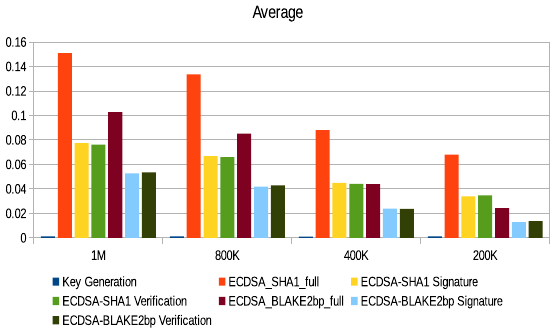
Figure 24. Average execution time of ECDSA algorithms with different data sizes.